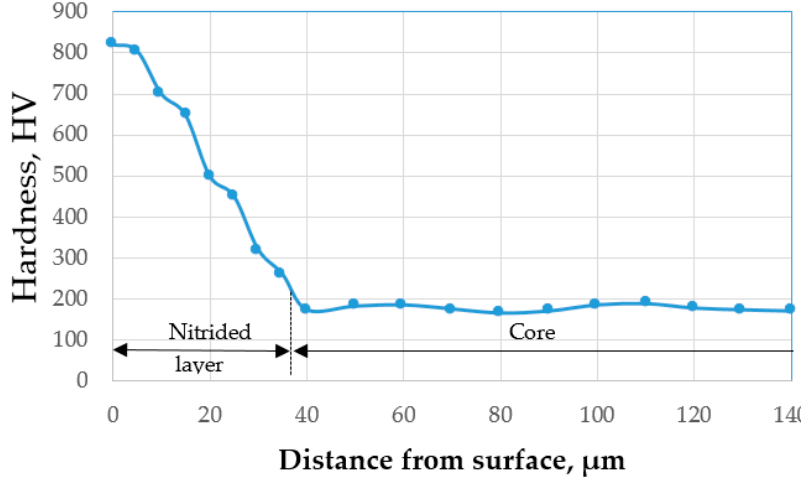
Figure 10. Hardness gradient curve on the cross-section of the nitrided layer.